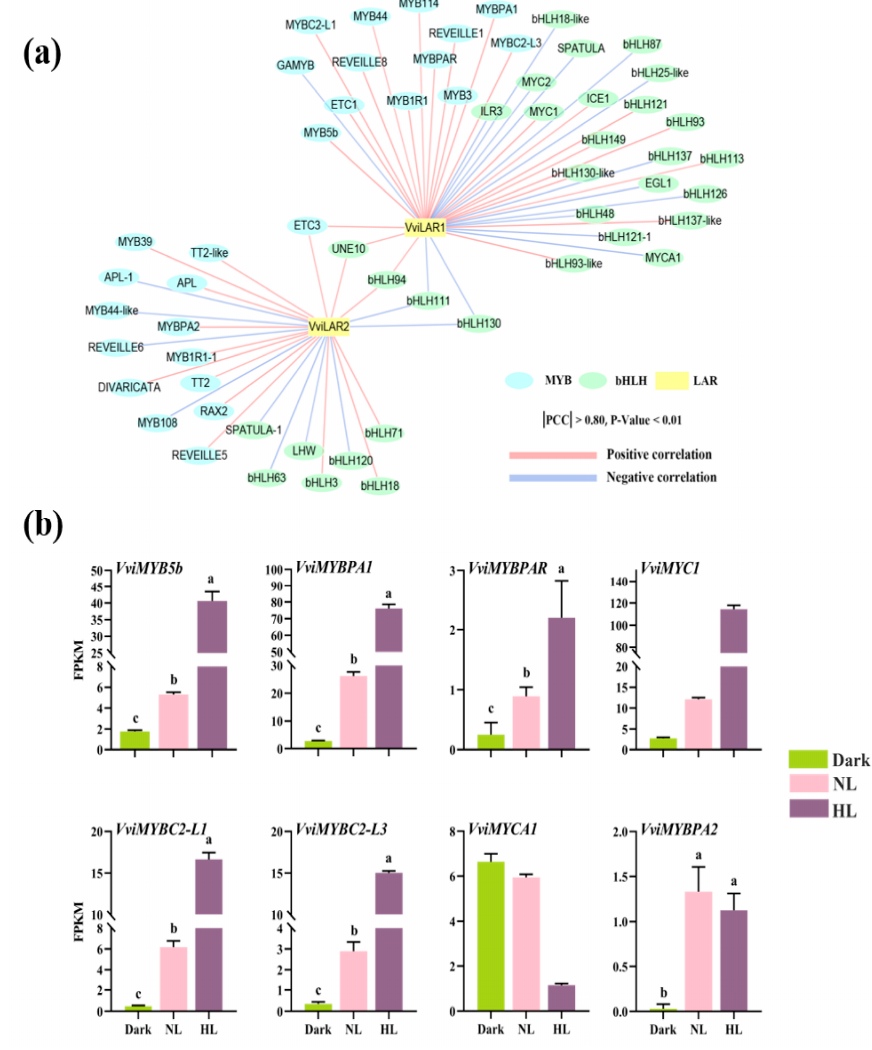
Figure 4. Screening for transcription factors (TFs) regulating two LAR genes’ expression in grapevine calluses. ( a ) Gene co-expression network between VviLARs and TFs. Structural genes and TFs are represented by square and oval, respectively. Lines in light red and light blue represent positive or negative associations between LAR genes and TFs (|PCC| > 0.8; p < 0.01). ( b ) The expressions of known TFs regulate trans -flavan-3-ol biosynthesis in grapevine calluses under different light intensity treatments. HL: grapevine calluses treated in high light; NL: grapevine calluses cultured in control condition. The expression level of TFs was estimated based on Fragments per Kilobase per Million Mapped Fragments (FPKM). Data are expressed as means ± SD of three biological replicates. Lower case letters indicated significant differences analyzed by one-way ANOVA tests.